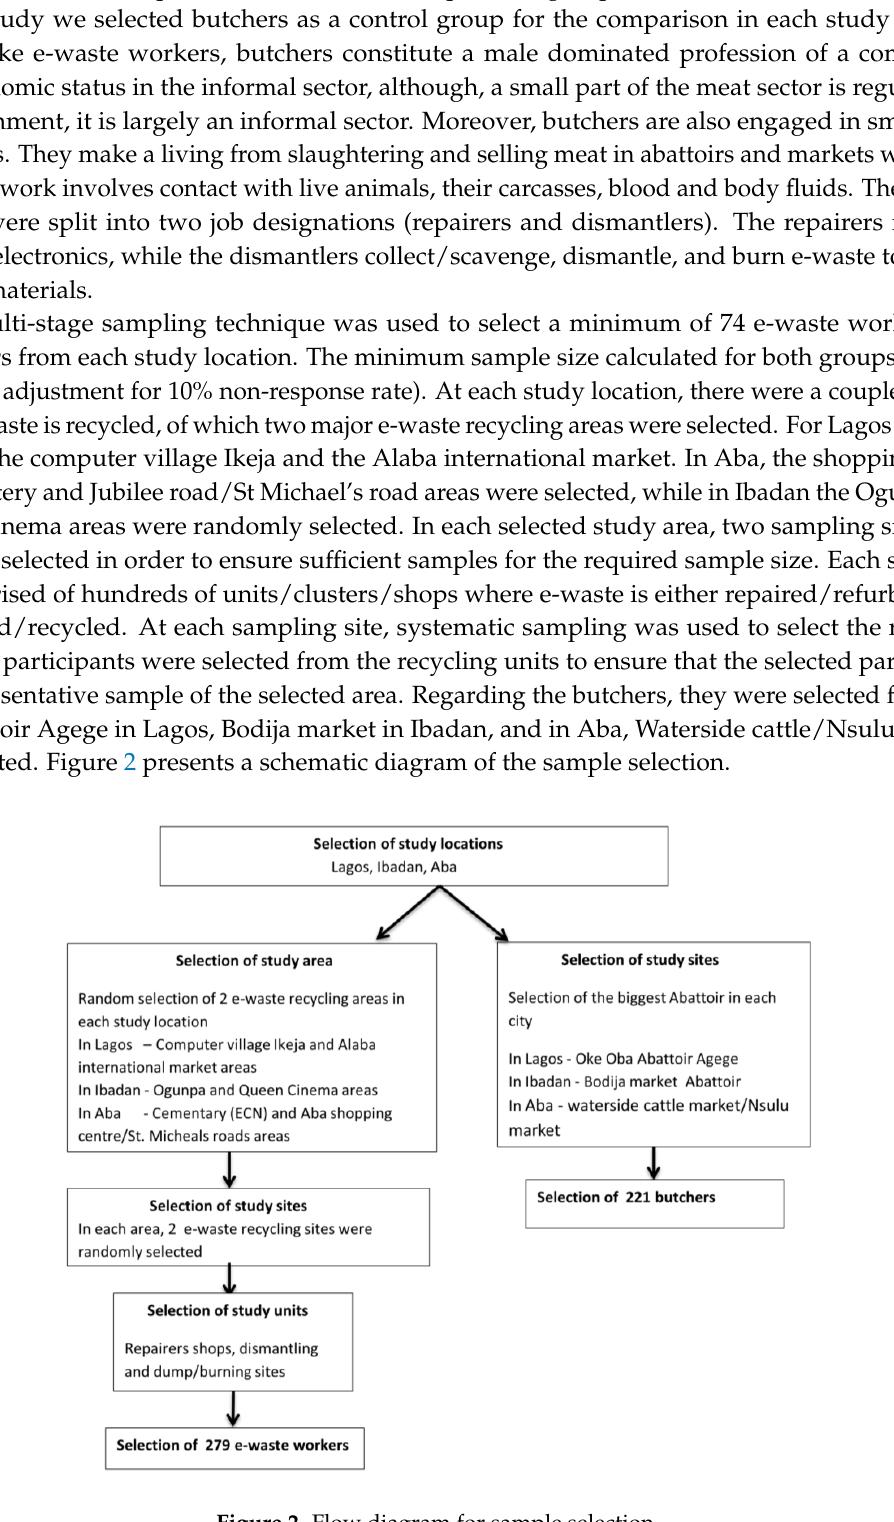
Figure 2. Flow diagram for sample selection.